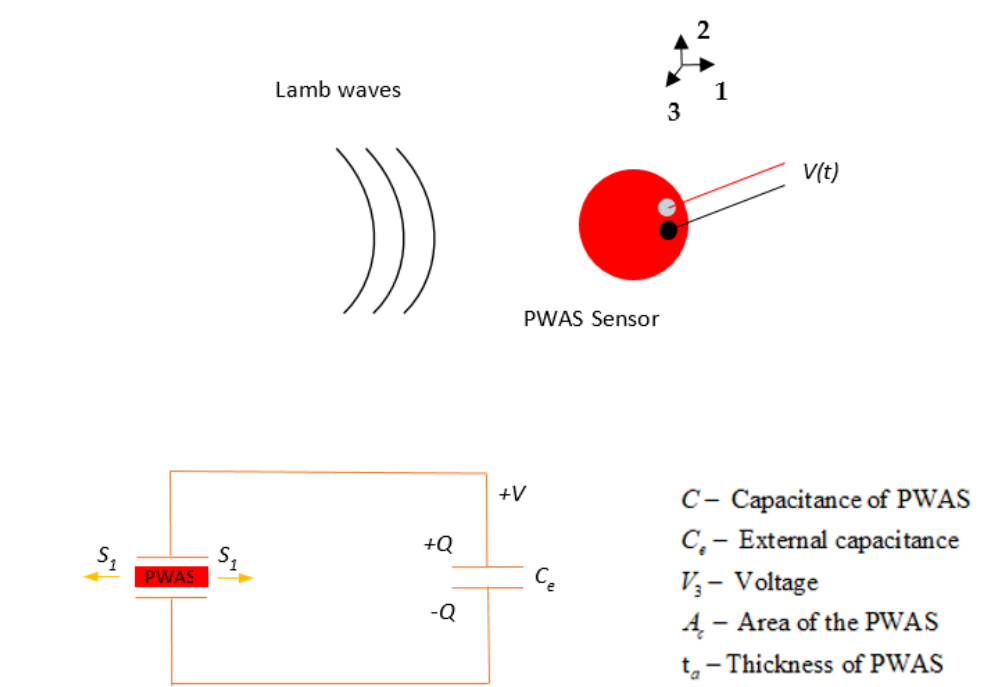
Figure 1. PWAS sensing mechanism schematic for Lamb wave detection.